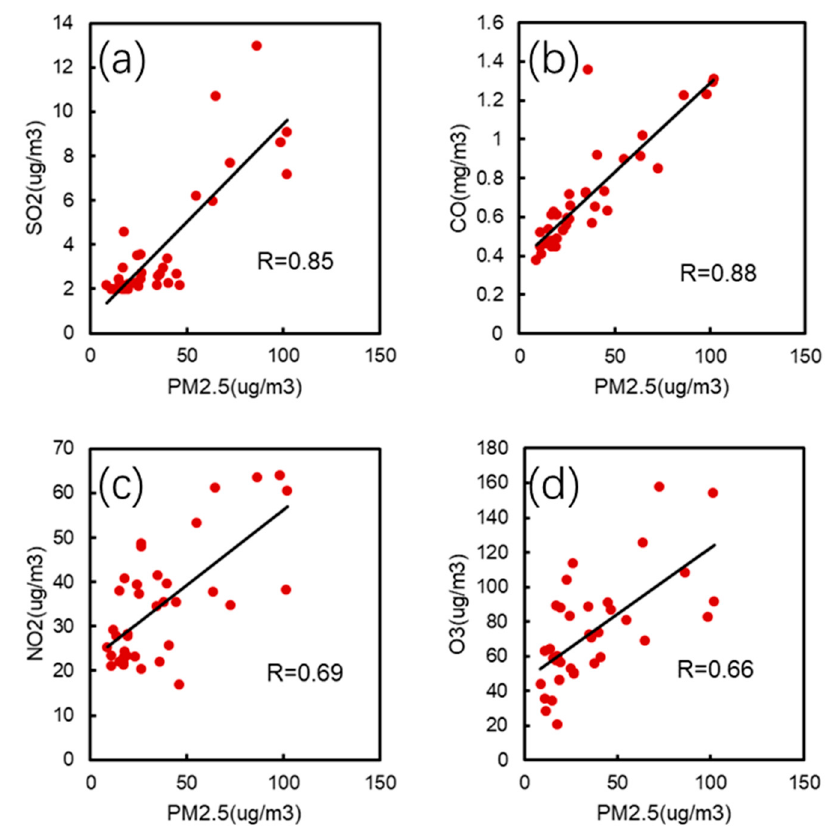
Figure 4. Plots ( a – d ), respectively, show the correlation graph array between PM 2.5 and SO 2 , CO, NO 2 , and O 3 . The correlation coefficient R values are given in the subplots, respectively.